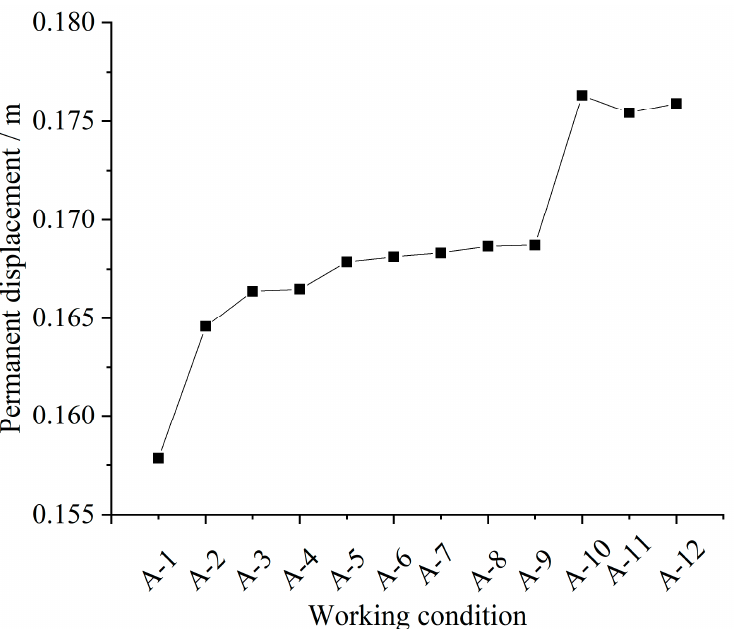
Figure 3. The permanent displacement under various working conditions of Table 1.